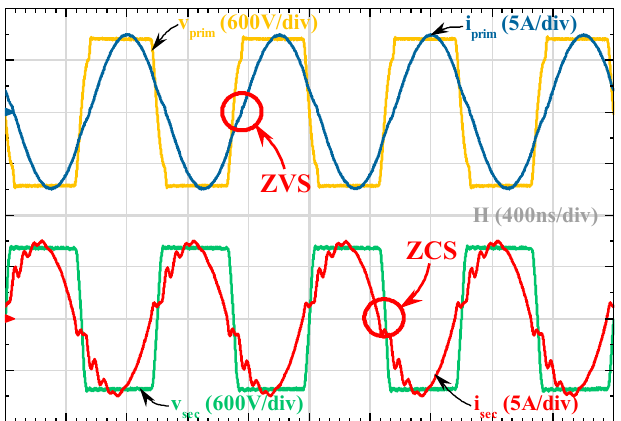
Figure 25. Experimental waveforms of the V IENNA rectifier with 800 V battery voltage and full load ( P ac = 11 kW).